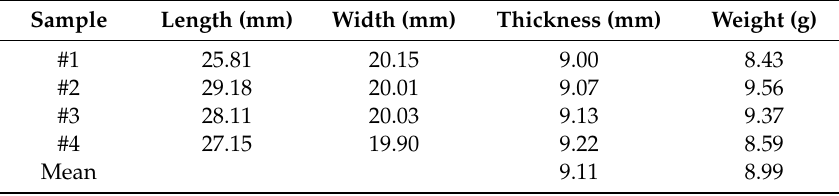
Figure 7. Weight measurement of specimens using an electronic scale. Table 4. Dimensions of specimens taken from design hull plate with Gc of 64 wt.%.